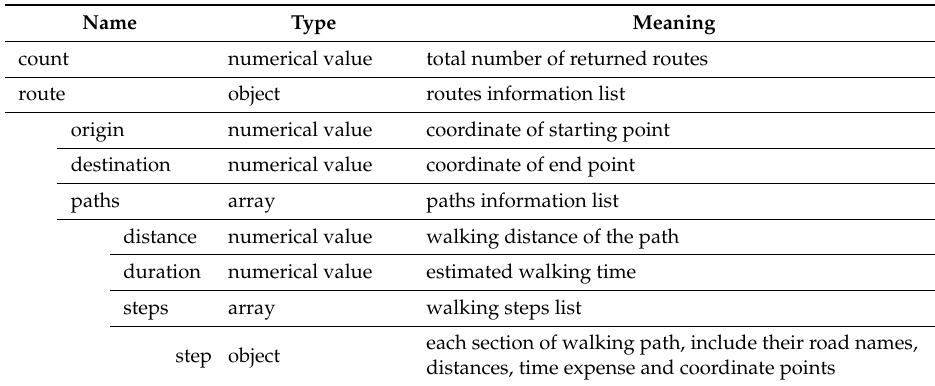
Table 1. Main outputs of AMap’s walking route planning